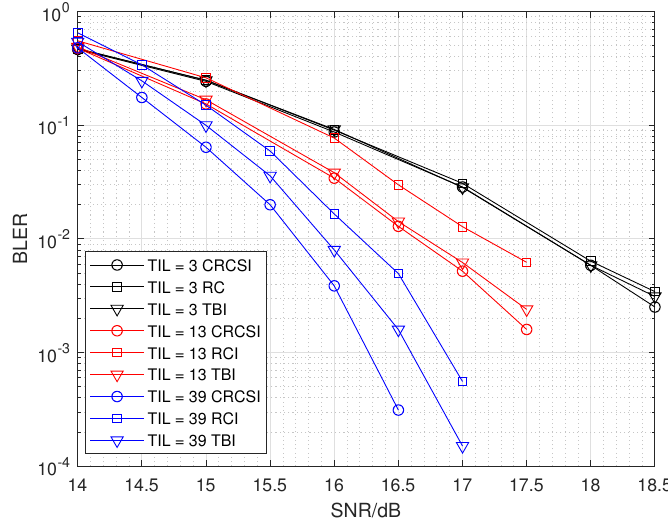
Figure 6. Comparison for mobile